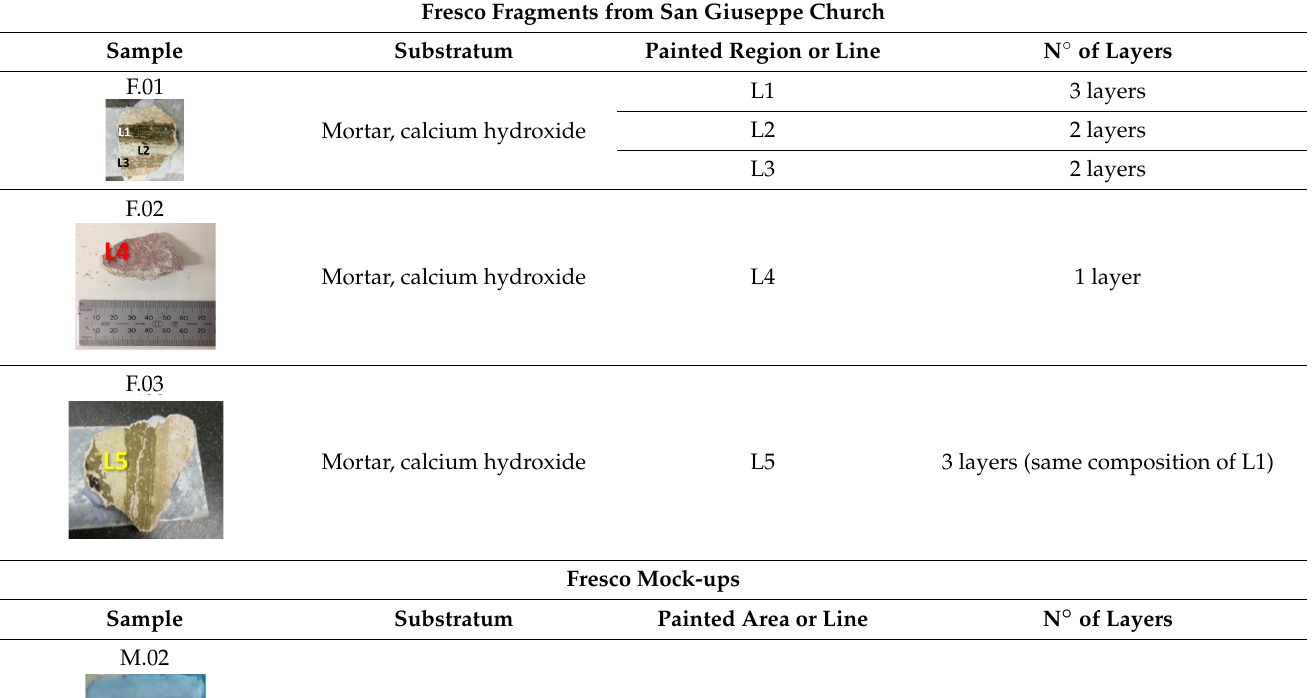
Table 1. Real fresco samples and mock ‐ ups.